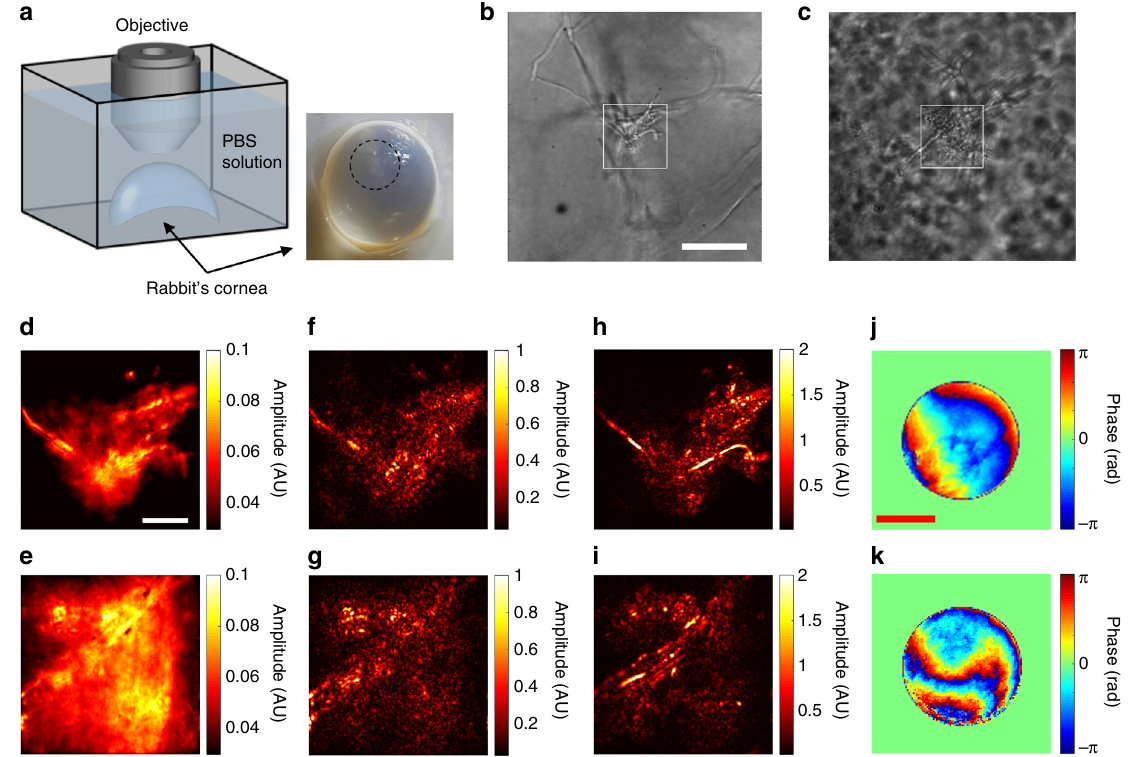
Fig. 5 Experimental demonstration of CLASS microscopy for imaging the hyphae of Aspergillus cells in a rabbit ’ s cornea. a Layout of the sample geometry. A rabbit ’ s cornea infected by A. fumigatus was immersed in PBS solution in a Petri dish and placed under the objective lens. The black dashed circle in the photo indicates the infection site. b , c Transmission images taken by illuminating the cornea from the bottom of the Petri dish in ( a ) using a light emitting diode ( λ = 780 nm). Scale bar, 40 µ m. d , e Incoherent addition of time-gated and angle-dependent re fl ection images for the white rectangular boxes are shown in ( b , c ) respectively. Scale bar, 10 µ m. f , g Images taken by CASS microscopy in the epi-detection geometry for the white rectangular boxes are shown in ( b , c ) respectively. h , i Same as ( f , g ) respectively, but after applying CLASS algorithm. Color bar, intensity in arbitrary unit. j , k Specimen-induced aberration maps identi fi ed during the acquisition of ( h , i ) respectively. Scale bar, k 0 α . Color bar, phase in